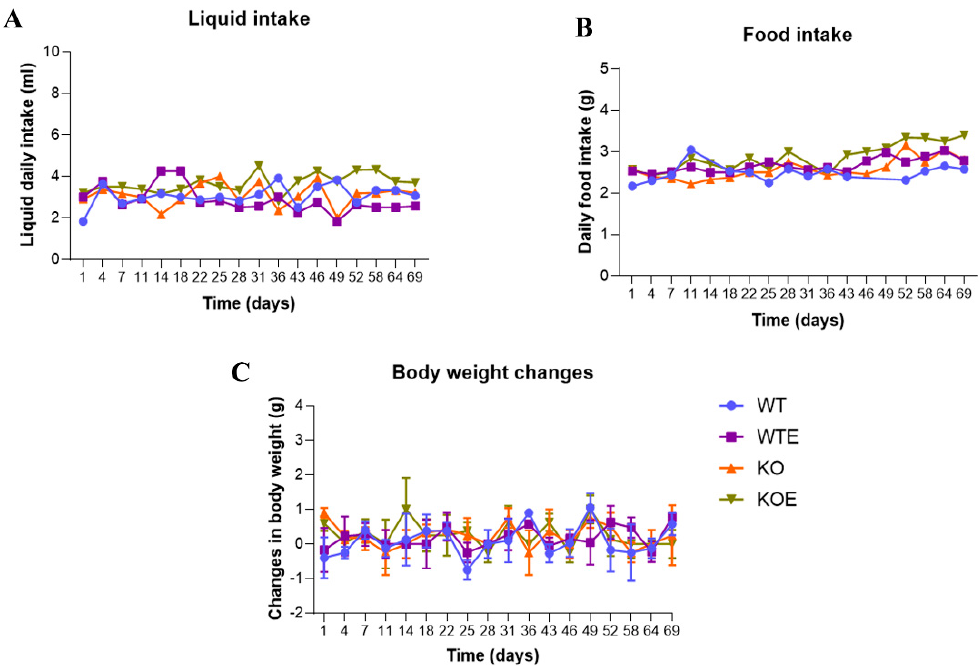
Figure 2. Diet dynamics in mice. ( A ) Liquid intake (water and water containing 10% ( v / v ) alcohol) in the WT, chronic ethanol-treated WT, TLR4-KO, and chronic ethanol-treated TLR4-KO animals during treatment. ( B ) Solid food intake in the four experimental groups of animals during treatment. ( C ) Variations in mouse body weight throughout alcohol treatment in the four experimental groups. No significant changes were observed in the different experimental groups. N = 4 per group.